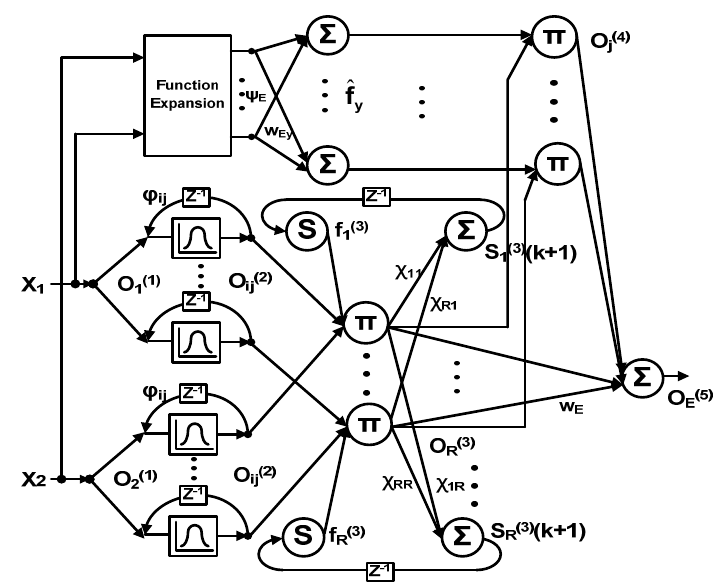
Figure 5. FLNRFNN structure.